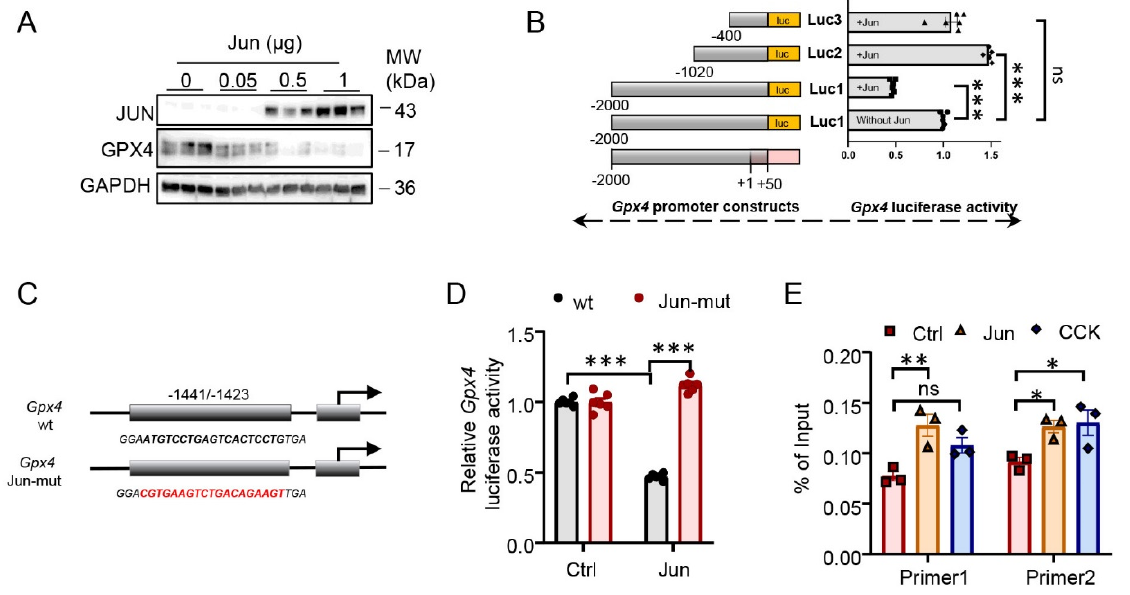
Figure 3. Jun inhibited glutathione peroxidase 4 ( Gpx4 ) transcription. ( A ) The protein level of Jun or